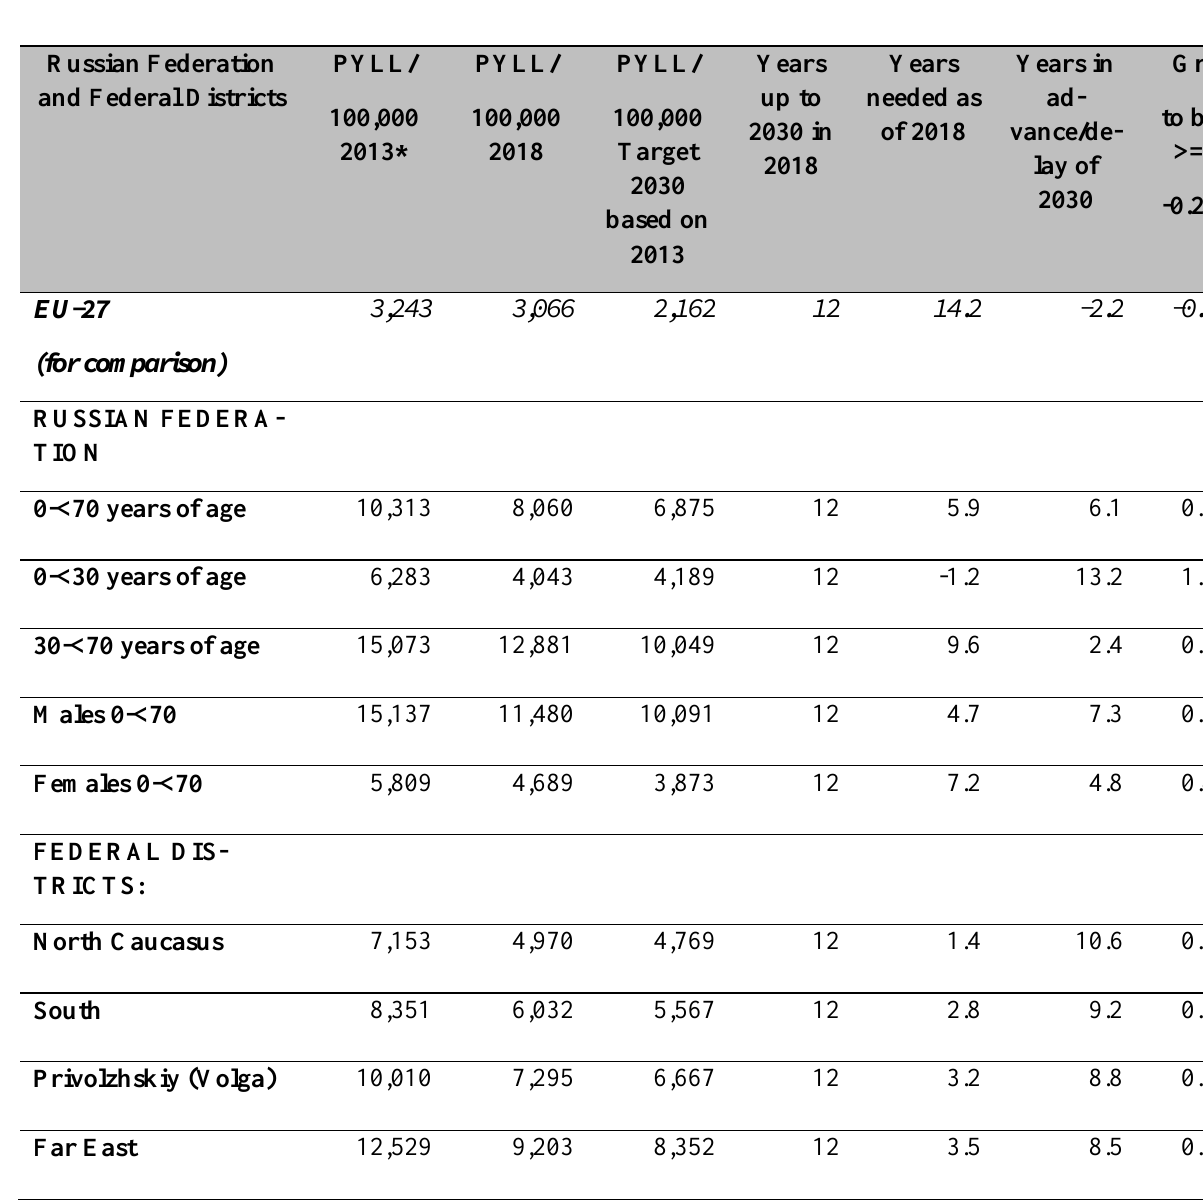
Table 1. Projected reduction of Premature Years of Life Lost (PYLL) targeted